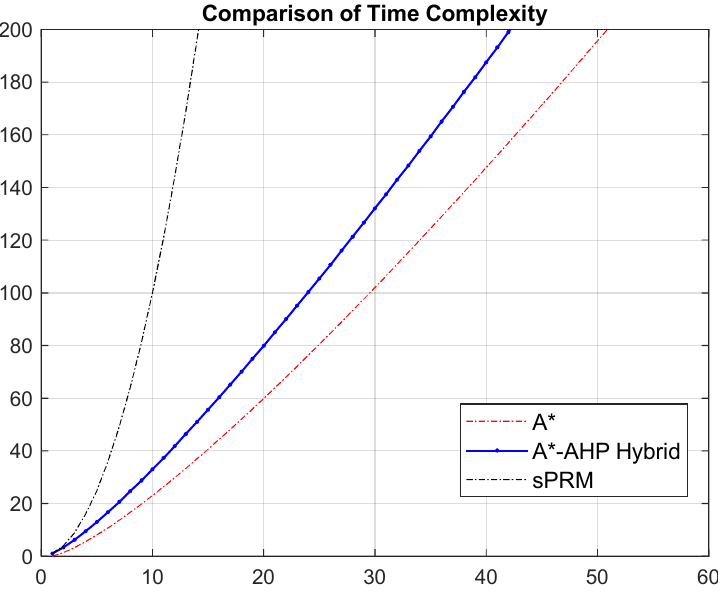
Figure 11. Comparison of algorithm complexity.